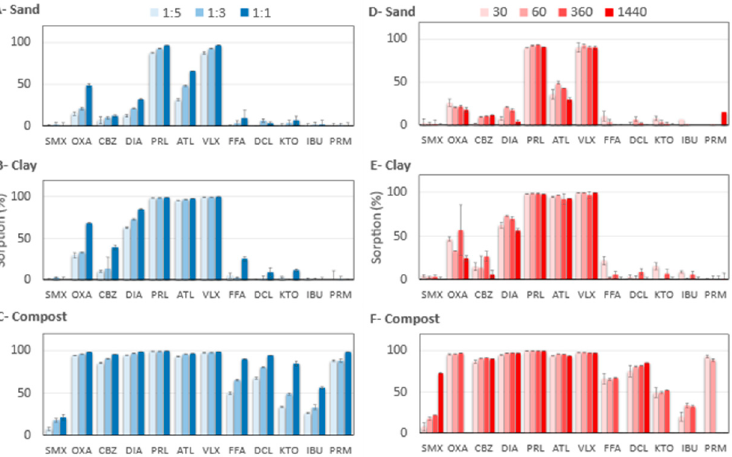
Figure 1. In fl uence of the solid:water ratio (volumetric) ( A – C ) (tested for contact time of 60 min) and in fl uence of the contact time (in minutes) ( D – F ) (tested for a material:water ratio of 1:3) on the sorp- tion of the selected PhACs on sand ( A , D ), clay ( B , E ), and compost ( C , F ) in batch experiments per- formed with milli-Q water and crushed materials. Errors bars display the variability within the three replicates.